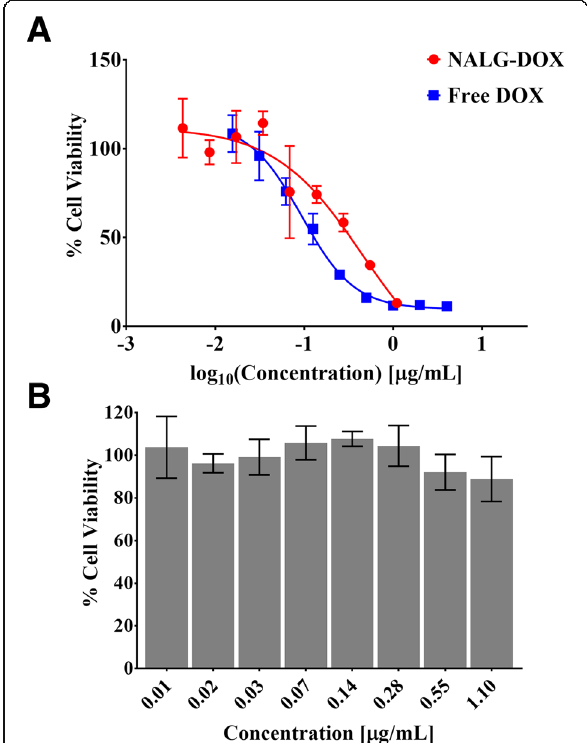
Fig. 6 Cell viability of 4T1-luc2-GFP cells after 72-h exposure to NALG-DOX and DOX ( a ) and NALG ( b ) at various concentrations. Data points and error bars indicate mean ± standard deviation from n = 3 wells. Concentrations indicate amount of DOX, either free or in particle, in ( a ). In b , NALG wells were dosed starting at same particle concentrations as NALG-DOX, indicating little to no cell death from drug carrier